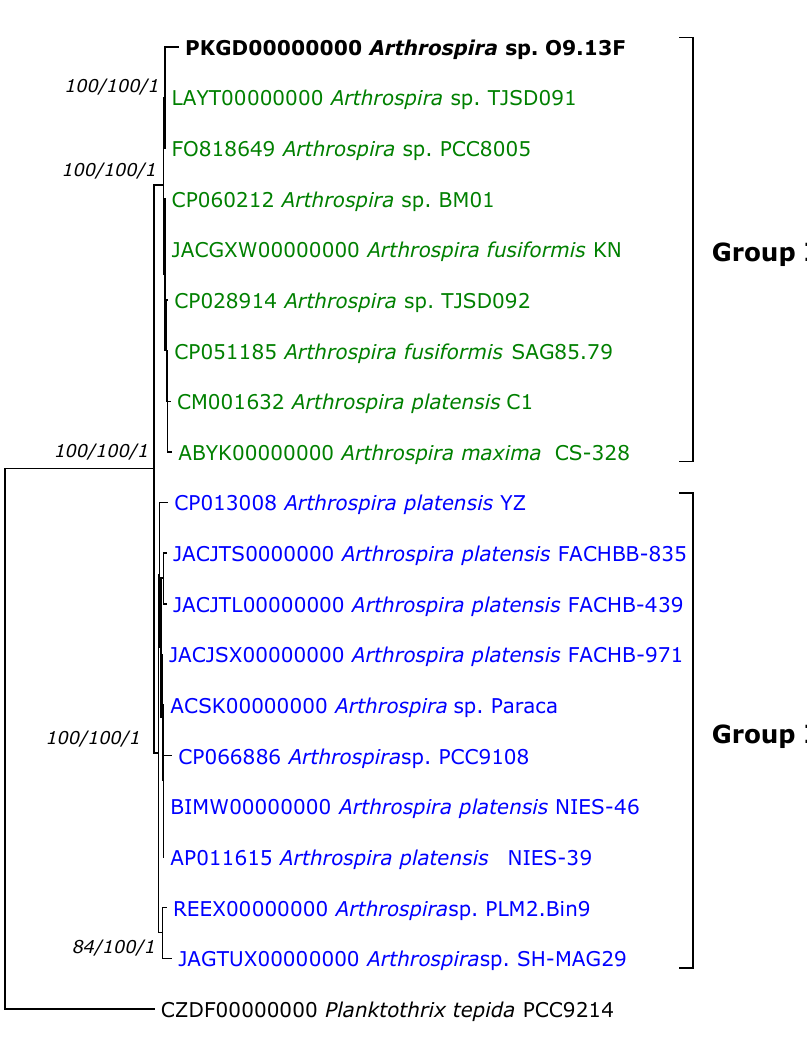
Figure 6. Maximum Likelihood tree indicating the current relatedness of Arthrospira sp. O9.13F.